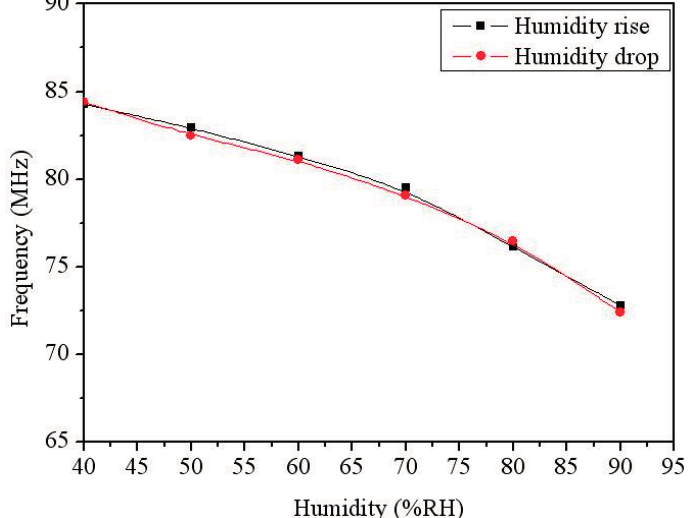
Figure 11. Measured output frequency of the integrated humidity sensor at 30 °C.